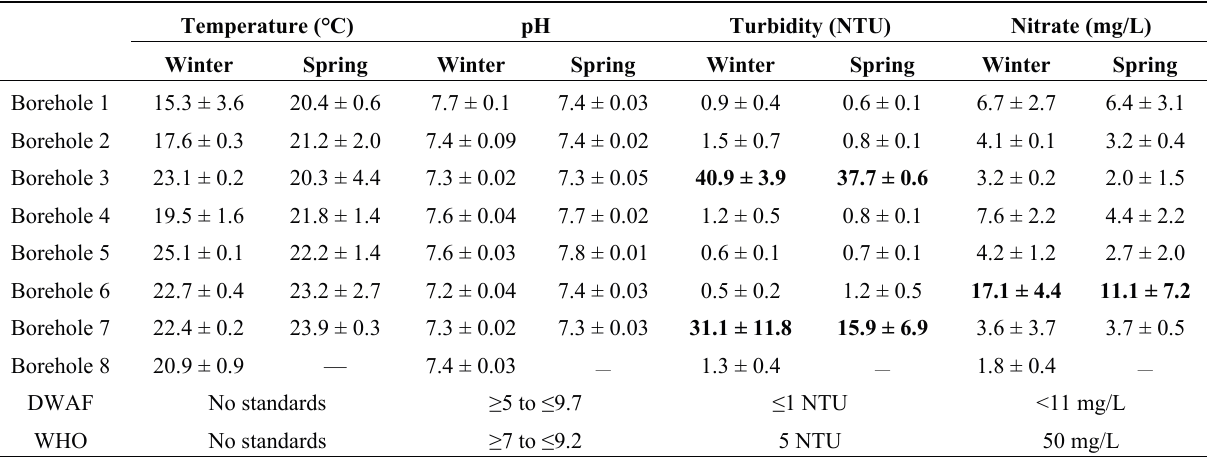
Table 1. Physico-chemical analyses of water samples for winter and